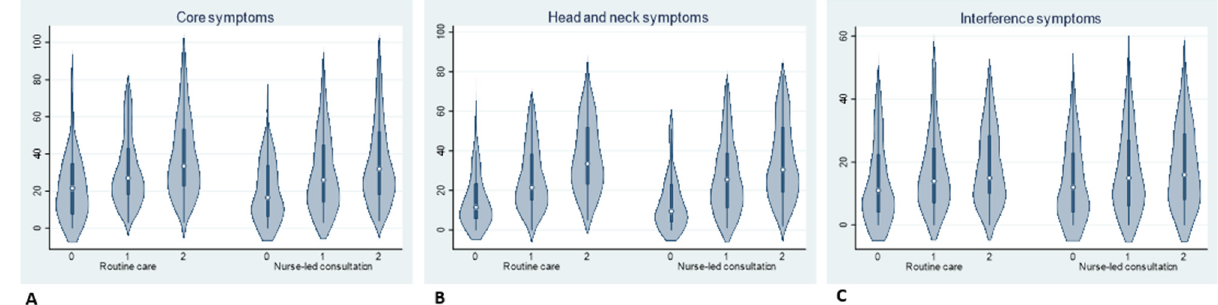
Figure 2. Distribution of data in the routine care and consultation group at three different times across the main MDASI-HN dimensions: core symptoms ( A ); head and neck symptoms ( B ); and interference symptoms ( C ).